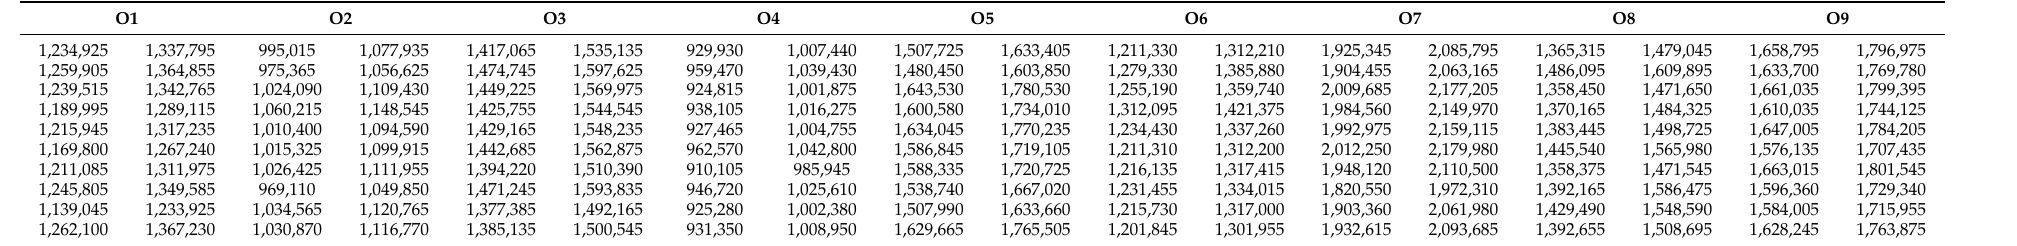
Table 2. Best compromise solution for each DM (the i -th row corresponds to the i -th DM).